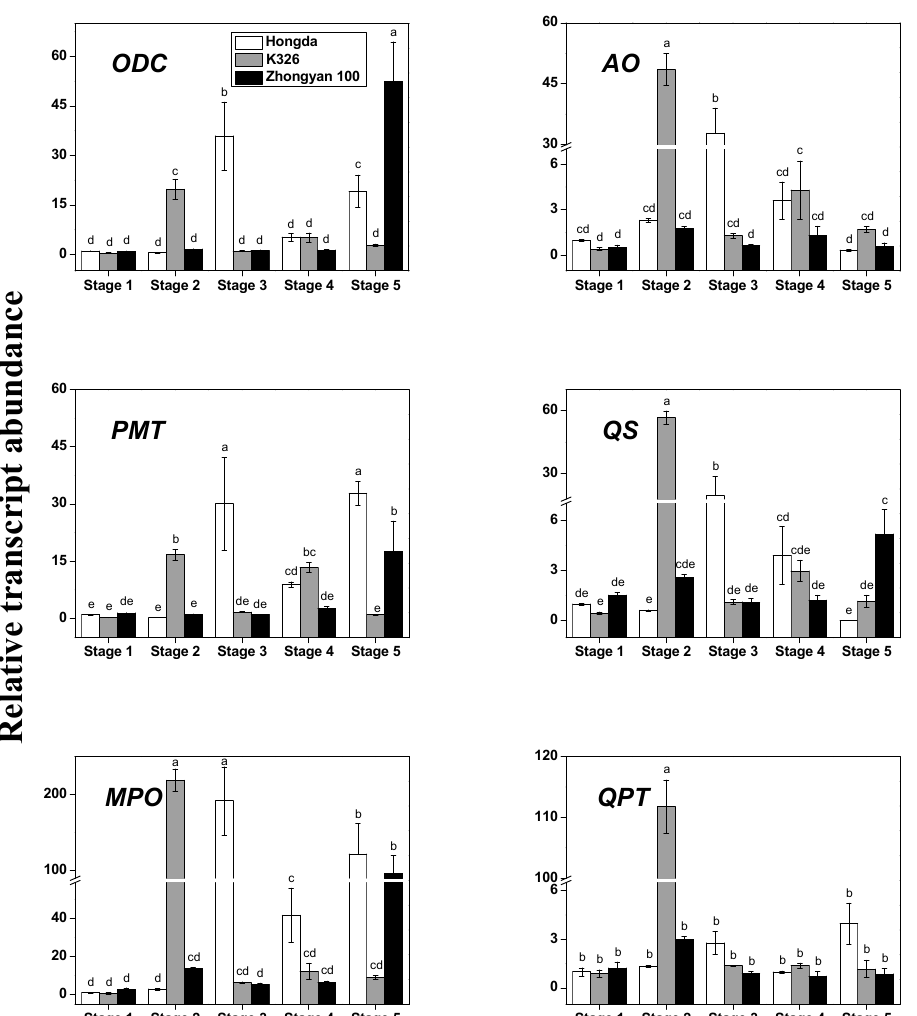
Figure 3. Relative transcript abundance of alkaloid biosynthesis genes in Nicotiana tabacum leaves among different varieties and developmental stages. Stage 1, rosette stage; Stage 2, vigorous growing stage; Stage 3, lower leaves maturing stage; Stage 4, middle leaves maturing stage; Stage 5, upper leaves maturing stage. Each value represents the mean ( n = 3). Values in the same gene followed by the same letter are not significantly different at p < 0.05. Table 4. Correlation coefficient between gene transcription levels at the vigorous growing stage and alkaloids contents in Nicotiana tabacum leaves.